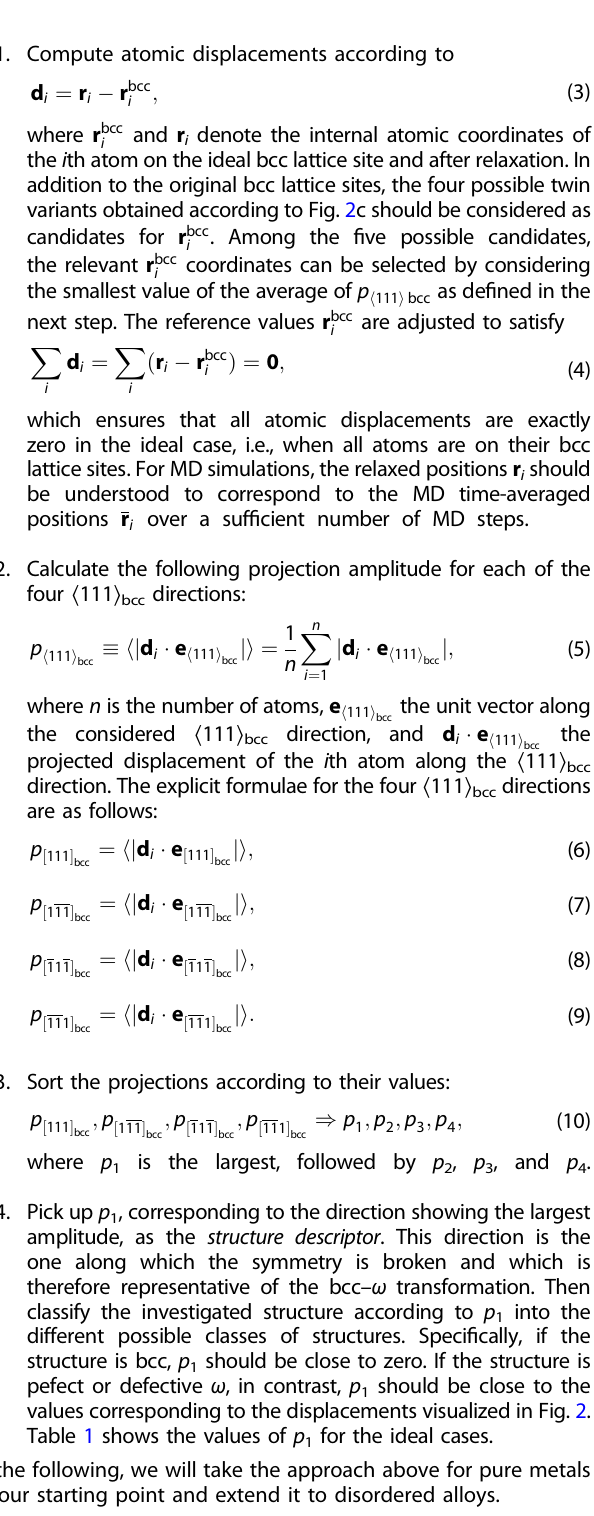
Table 1. { p 1 , p 2 , p 3 , p 4 } values for several ideal cases in units of c ω (cf. Eq. (2)).